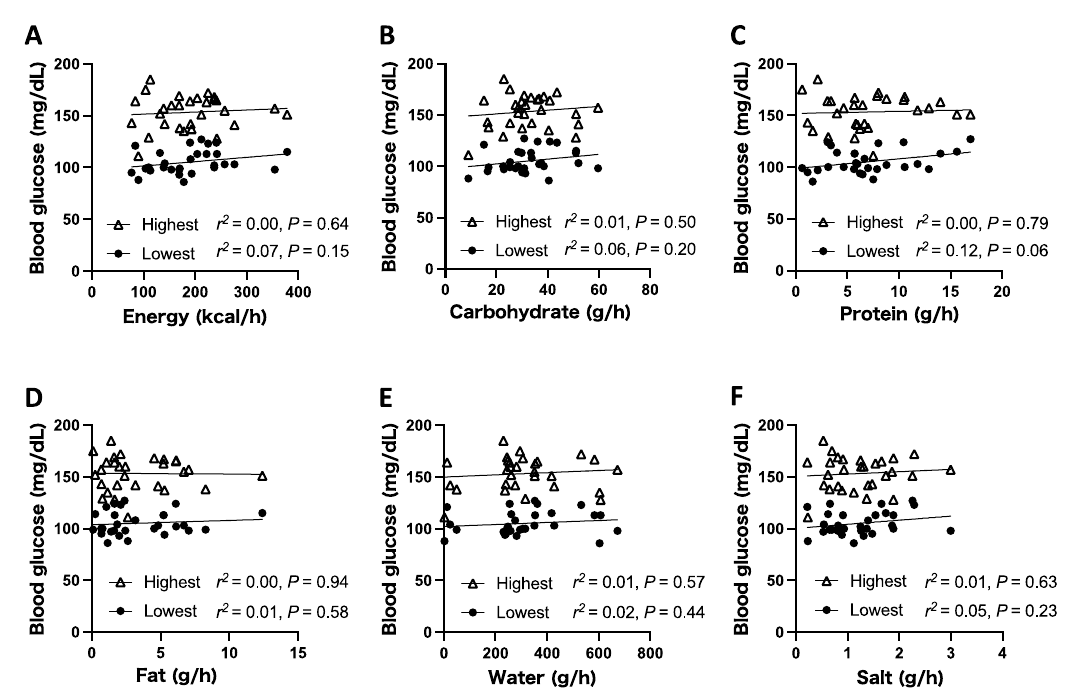
Figure 2. Scatter plots showing the relationships between nutrient intake and blood glucose level. The intake of energy ( A ), carbohydrate ( B ), protein ( C ), fat ( D ), water ( E ), and salt ( F ) was calculated according to the consumed food and fluid products. Each plot indicates one segment.